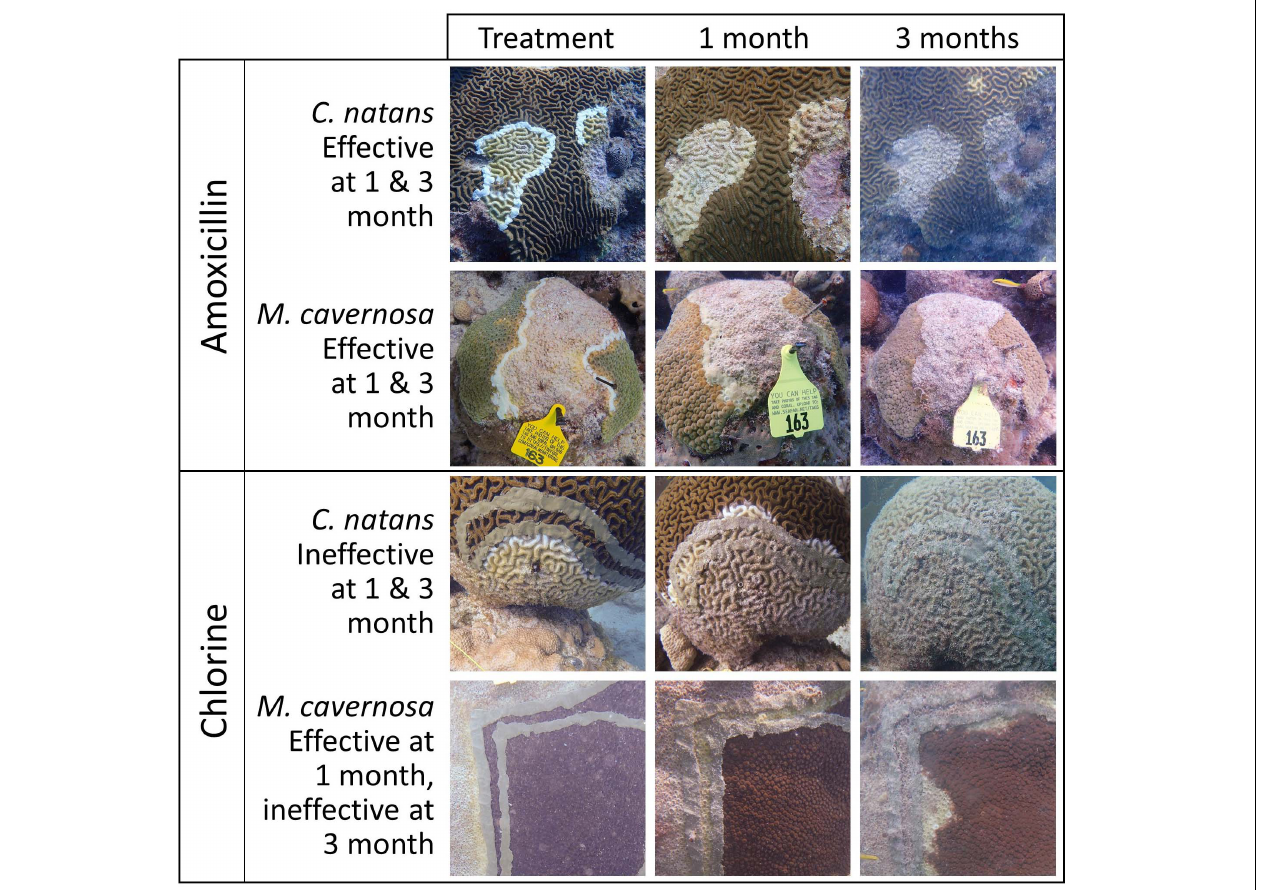
FIGURE 4 | Time series photos showing effective amoxicillin treatments and ineffective chlorinated treatments on two coral species: Colpophyllia natans (CNAT) and Montastraea cavernosa (MCAV). Disease lesions were defined as ineffective only once they had crossed both the margin and disease break chlorinated epoxy